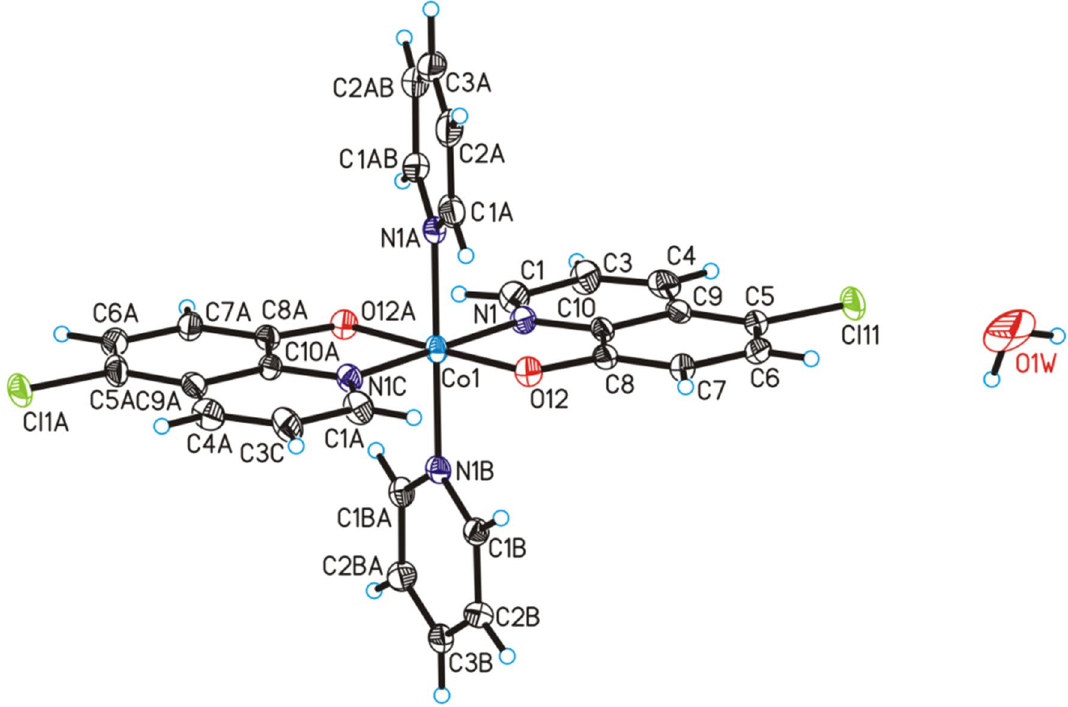
Figure 1. Molecular structure of the title compound in the crystal showing the atom labelling scheme and 25% probability displacement ellipsoids (H atoms are spheres of arbitrary size; disordered part of water molecule have been